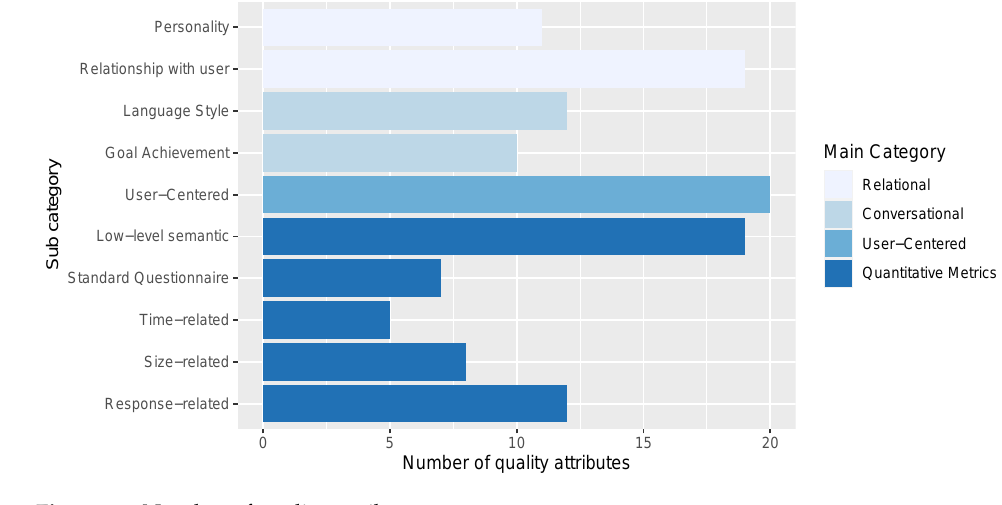
Figure 11. Number of quality attributes per category.